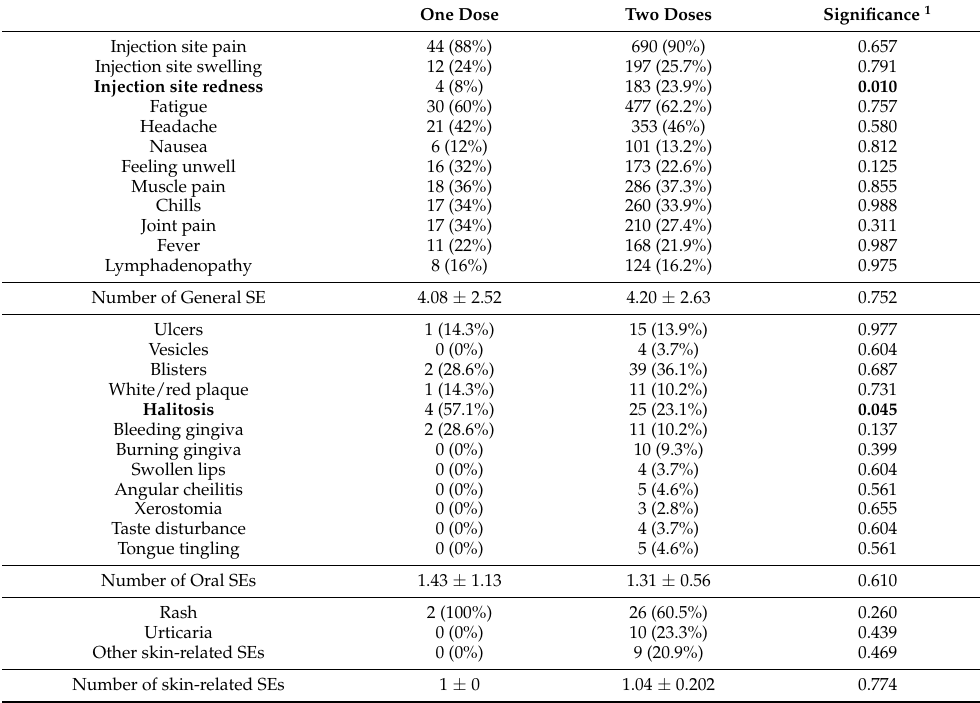
Table 10. Number of doses and the side effects of Pfizer–BioNTech COVID-19 vaccine among healthcare workers in the Czech Republic, January–February 2021. One Dose Two